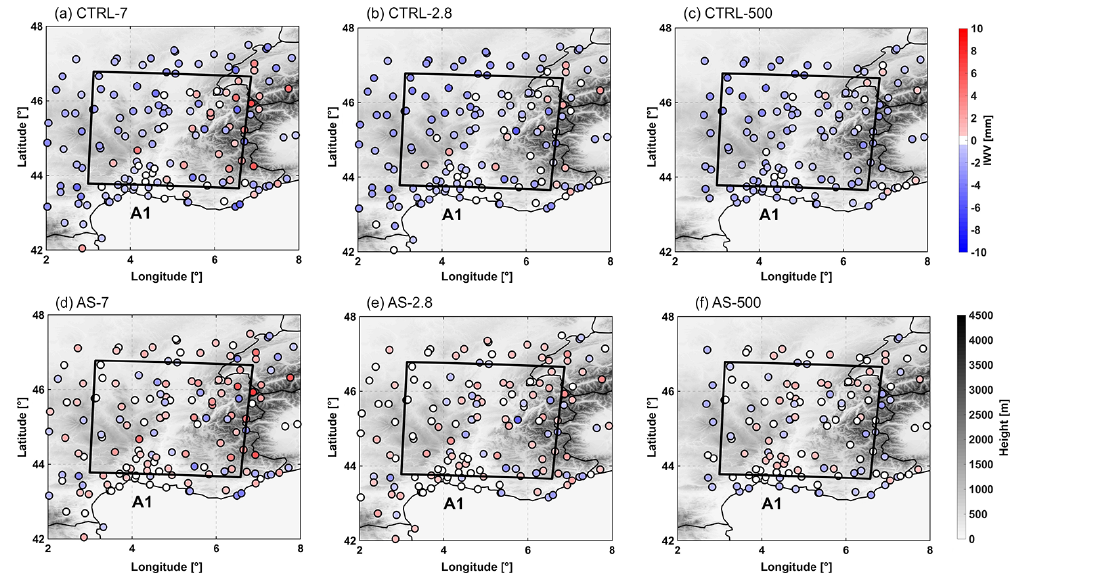
Figure 2. Spatial distribution of the 24-Hourly averaged IWV differences (GPS – COSMO). On the 23 September 2012 starting at